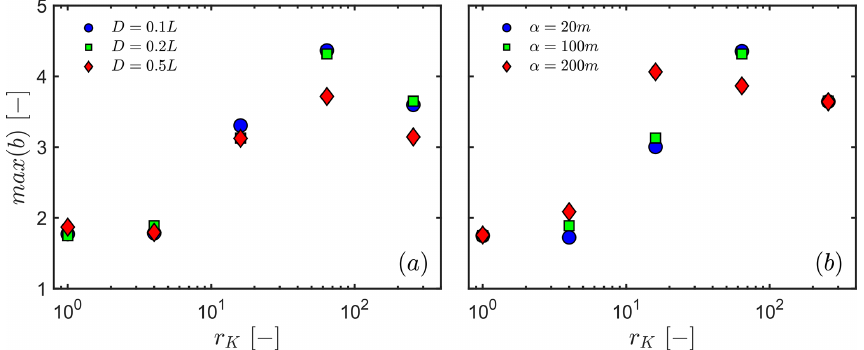
Figure B1. Maximum values of b as a function of r K for β = 0 . 2 and (a) variations in the thickness of the upper compartment, D , and (b) variations in the characteristic depth over which hydraulic properties decrease, α .